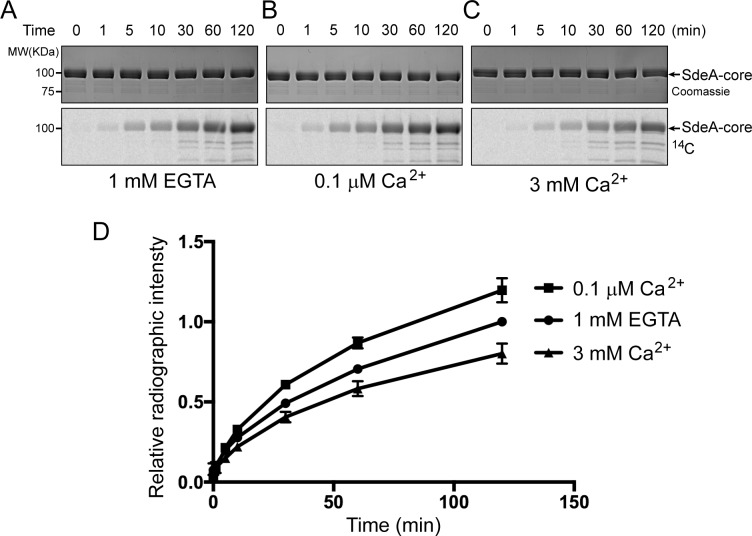
Reaction time course of SidJ in varied Ca2+ concentrations.(A) In vitro glutamylation time course of SdeA by SidJ with a concentration of 20 nM SidJ–CaM in buffer containing 1 mM EGTA. Reaction time points were collected and time is labeled above the graph in minutes. The proteins in the reactions were visualized by SDS-PAGE followed by Coomassie staining (top panel) and the glutamylation of SdeA was detected by autoradiography (bottom panel). (B) In vitro glutamylation time course of SdeA as in panel (A), with a buffer condition containing 0.1 μM Ca2+ instead of EGTA. (C) In vitro glutamylation time course of SdeA in the presence of 3 mM Ca2+. (D) A graph of the reaction time courses at three different Ca2+ concentrations. The relative radiographic intensity of each time point was normalized to the 120 min time point of the reaction with 1 mM EGTA. Each reaction was conducted in triplicate and error bars represent SEMs.